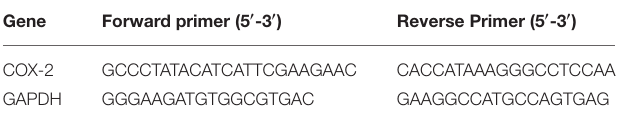
TABLE 2 | Primer sequences for the amplification of qRT-PCR products from canine cell